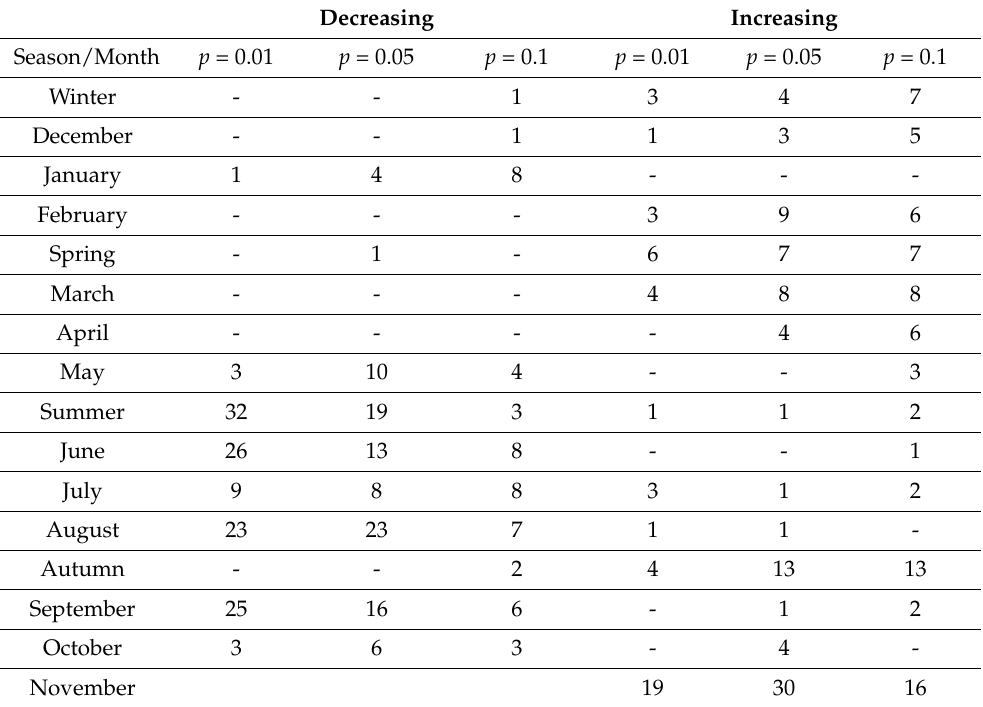
Table 4. The number of stations with trends at different level of